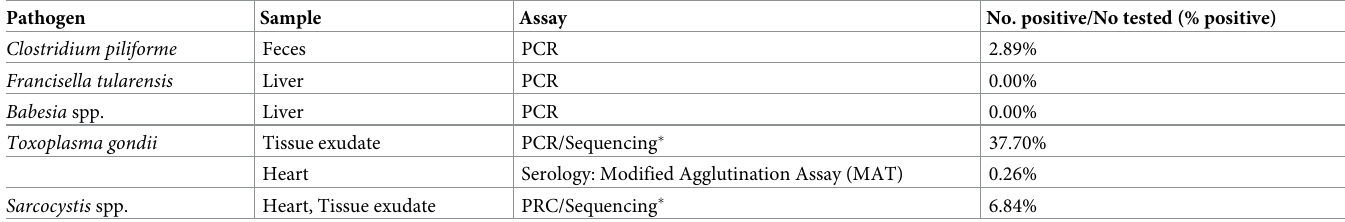
Table 3. Summary of active pathogen surveillance results in muskrats ( Ondatra zibethicus ) collected from Pennsylvania, USA, 2018–2019.